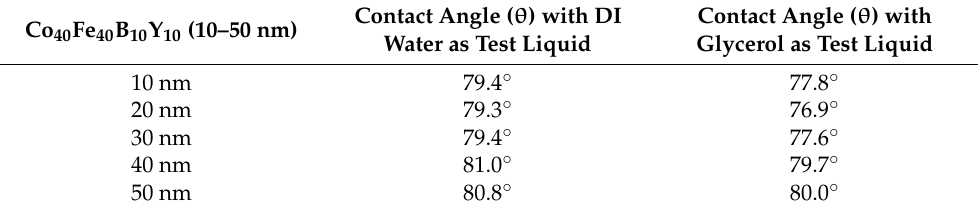
Table 4. Average contact angles of CoFeBY nanofilms after annealing at 100 ◦ C with DI water and glycerol.